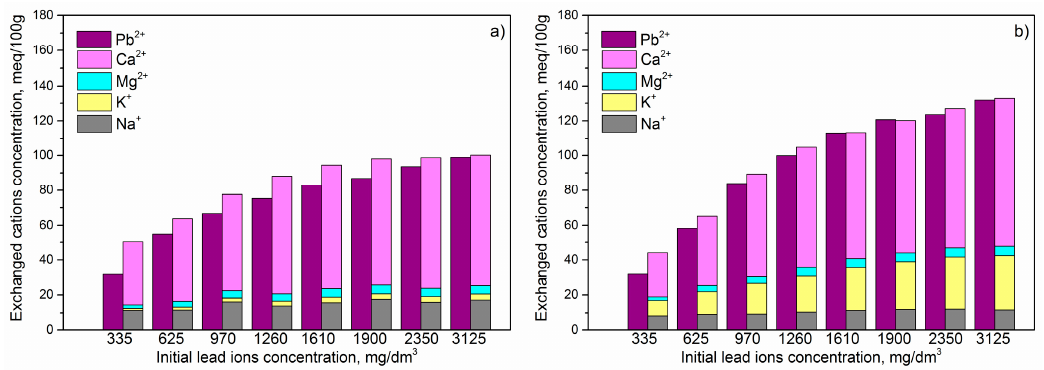
Figure 6. The amounts of Pb 2+ adsorbed and cations released for different initial Pb 2+ concentrations for NZA ( a ) and FeA ( b ).